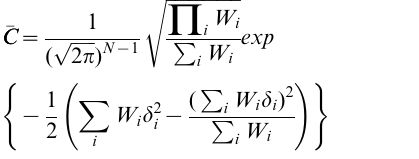
Figure S1 Power comparison between random-effect, fixed- effect meta-analysis and heterogeneity testing. Figure S2 The association result of the fixed effects meta analysis. Figure S3 Power comparison between random-effect meta- analysis and traditional wald test based approach. Figure S4 Power comparison between heterogeneity testing approach and traditional wald test based approach. Figure S5 Forest plot and PM-plot for Chr1:64752822 locus. Figure S6 Forest plot and PM-plot for Chr1:107271282 locus. Figure S7 Forest plot and PM-plot for Chr1:171199523 locus. Figure S8 Forest plot and PM-plot for Chr2:77837584 locus. Figure S9 Forest plot and PM-plot for Chr2:134421733 locus. Figure S10 Forest plot and PM-plot for Chr3:32944259 locus. Figure S11 Forest plot and PM-plot for Chr3:76066632 locus. Figure S12 Forest plot and PM-plot for Chr3:107430396 locus. Figure S13 Forest plot and PM-plot for Chr3:143466942 locus. Figure S14 Forest plot and PM-plot for Chr4:131925523 locus. ffiffiffiffiffiffiffiffiffiffiffiffiffiffiffiffi P W i i Figure S15 Forest plot and PM-plot for Chr5:119034507 locus. Figure S16 Forest plot and PM-plot for Chr8:46903188 locus. Figure S17 Forest plot and PM-plot for Chr8:64150094 locus. Figure S18 Forest plot and PM-plot for Chr8:84073148